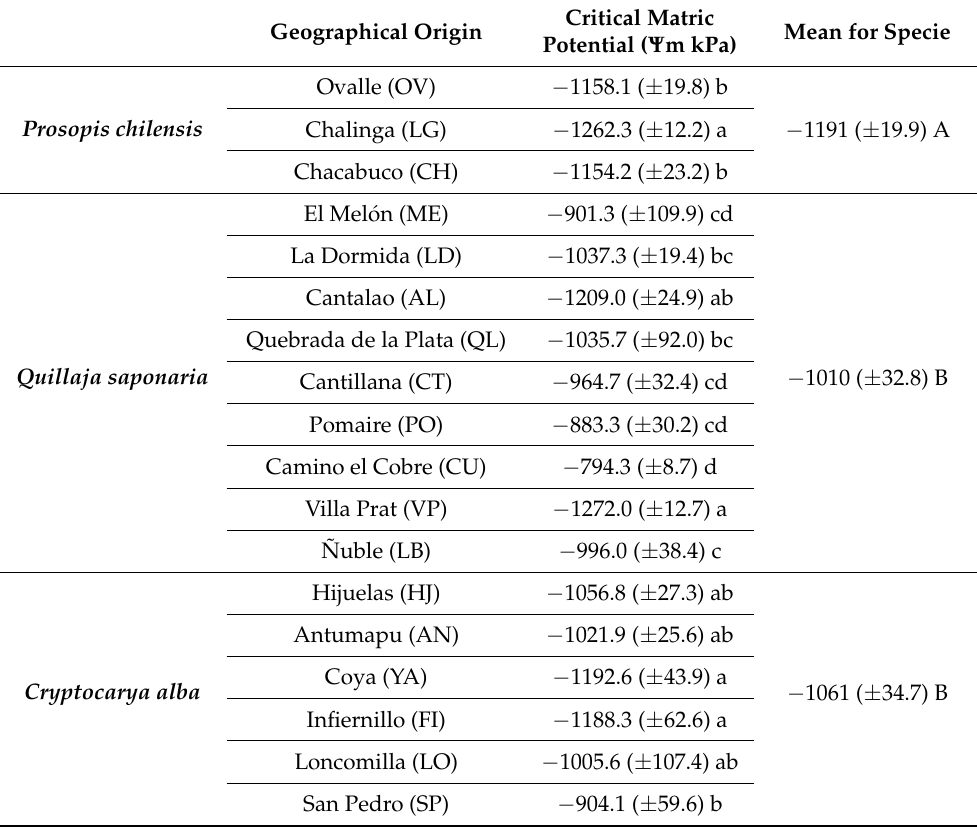
Table 2. Mean seed weight and standard error in parenthesis ( n = 4) per seed source for all the species. Lowercase letters indicate significant differences among seed sources for each species ( P. chilensis , Q. saponaria and C. alba ) for seed weight, according to non-parametric Kruskal–Wallis test ( p < 0.05). And capital letters statistically significant differences between species. According to the LSD-Fischer multiple comparison test ( p < 0.05).